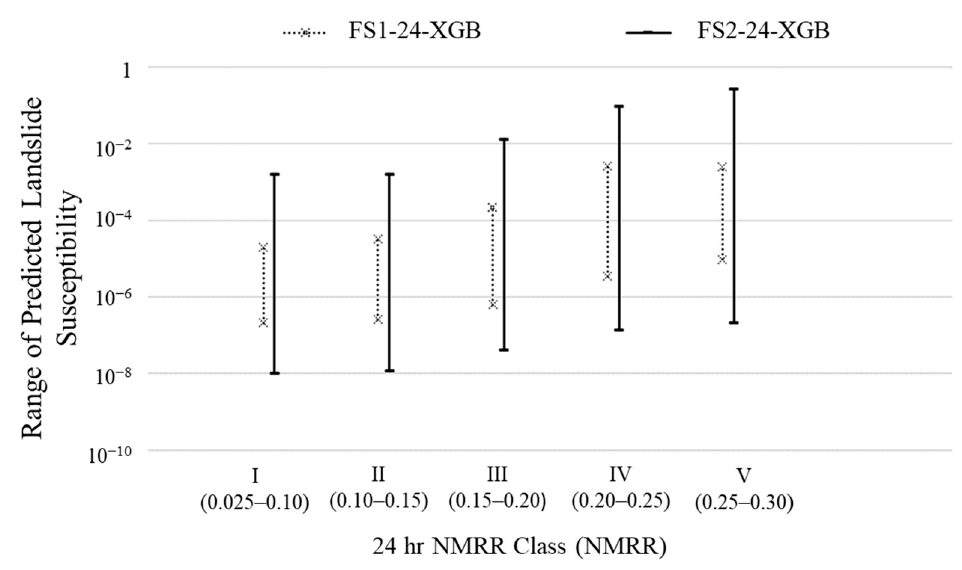
Figure 11. Ranges of Predicted Landslide Susceptibility.